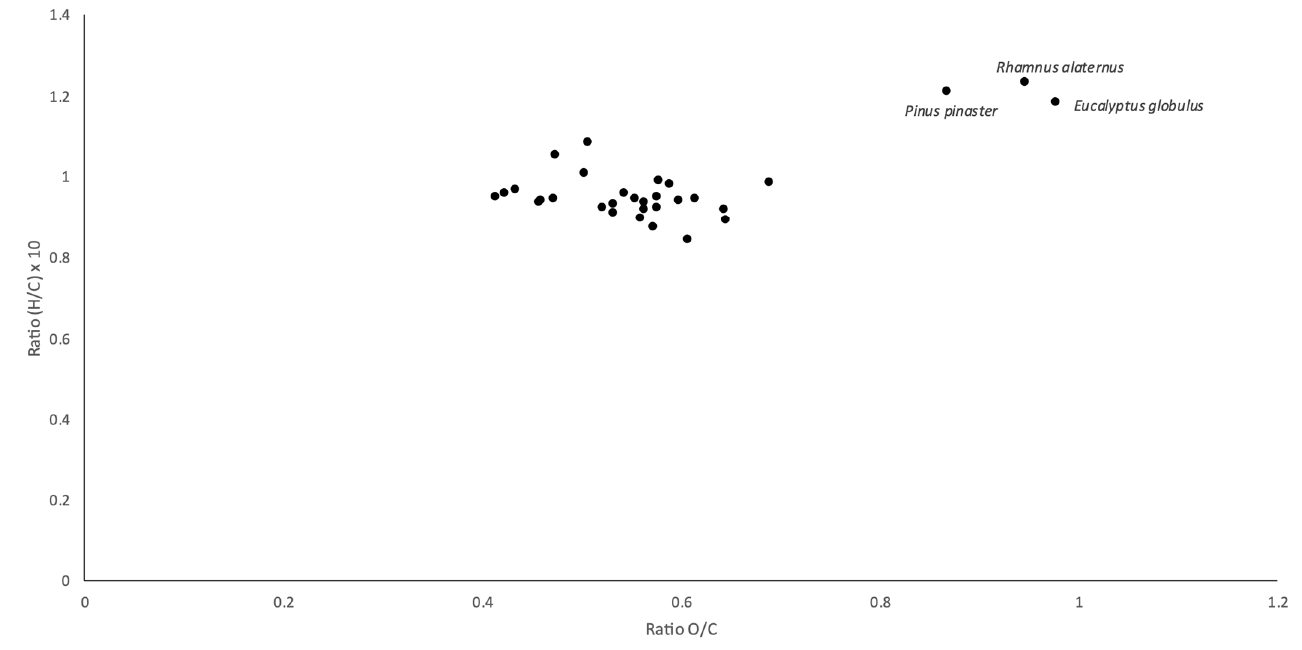
Figure 9. Van Krevelen diagram.